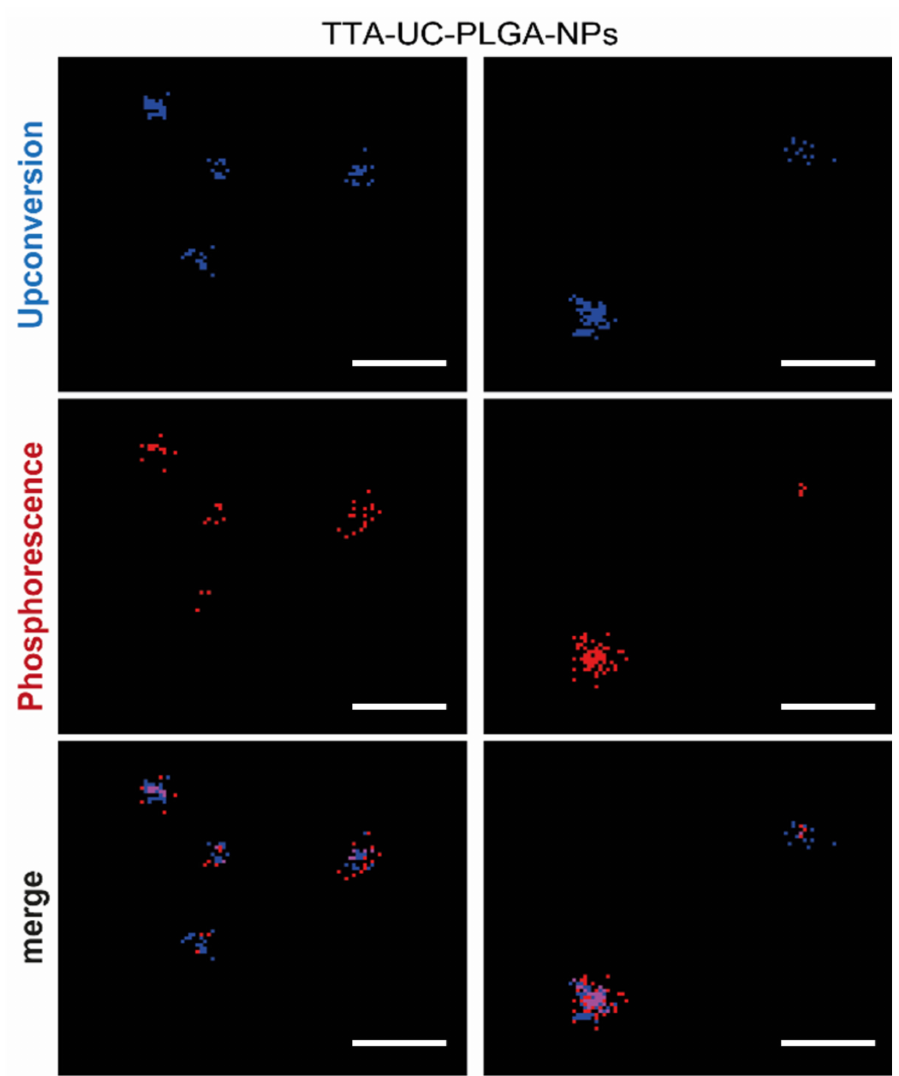
Figure 6. TTA-UC imaged by confocal microscopy. UC-TTA-PLGA-NPs were dissolved in water and imaged on a glass cover slip. The NPs were excited at 535 nm, and the following emission wavelengths were collected: 430–475 nm (blue) = upconversion, 650–670 nm (red) = phosphorescence. Scale white bar = 10 µ